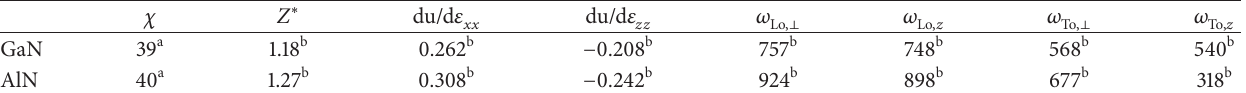
Table 4: Band gap pressure coefficients 𝜒 (meV/GPa), Born effective charges 𝑍 ∗ , and phonon frequencies 𝜔 𝐿𝑜 and 𝜔 𝑇𝑜 (cm − 1 ).